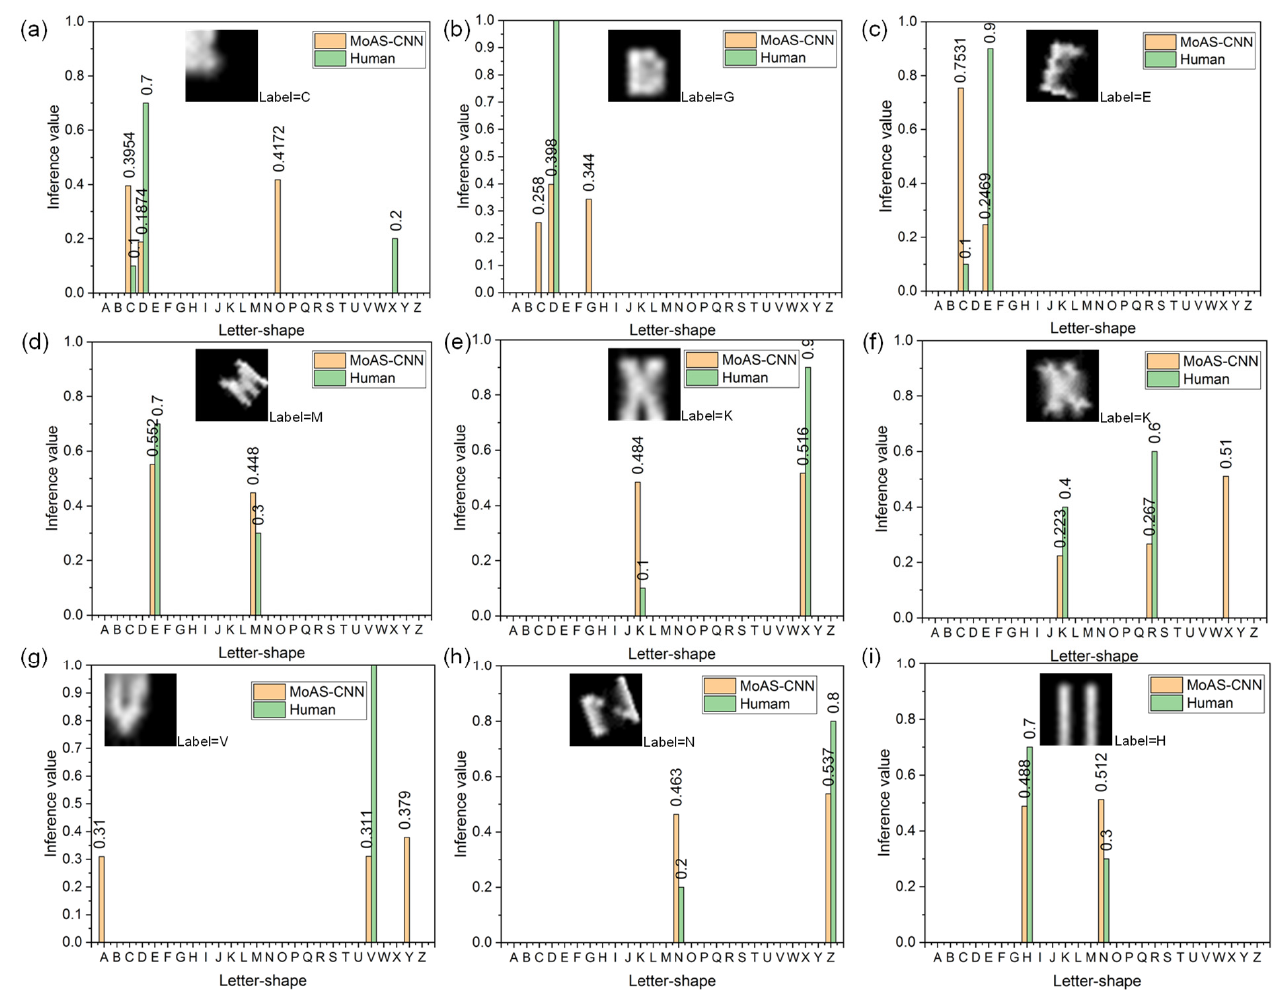
Figure 12. Comparison of recognition results between MoAS-CNN and human for some difficult samples. ( a ) Inference results of sample with label “C”, ( b ) inference results of sample with label “G”, ( c ) inference results of sample with label “E”, ( d ) inference results of sample with label “M”, ( e ) inference results of sample with label “K”, ( f ) inference results of sample with label “K”, ( g ) inference results of sample with label “V”, ( h ) inference results of sample with label “N”, ( i ) inference results of sample with label “H”.